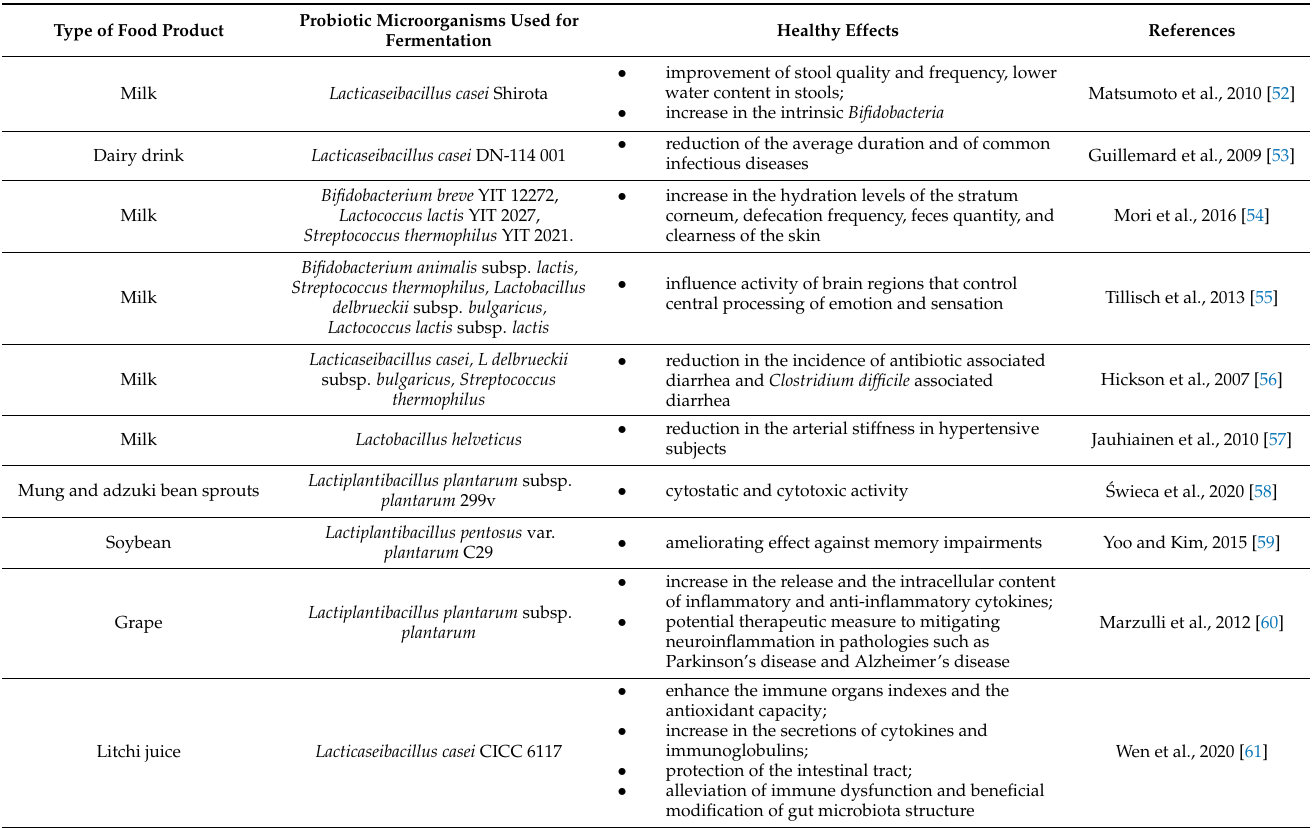
Table 1. Healthy benefits of foods fermented with probiotic